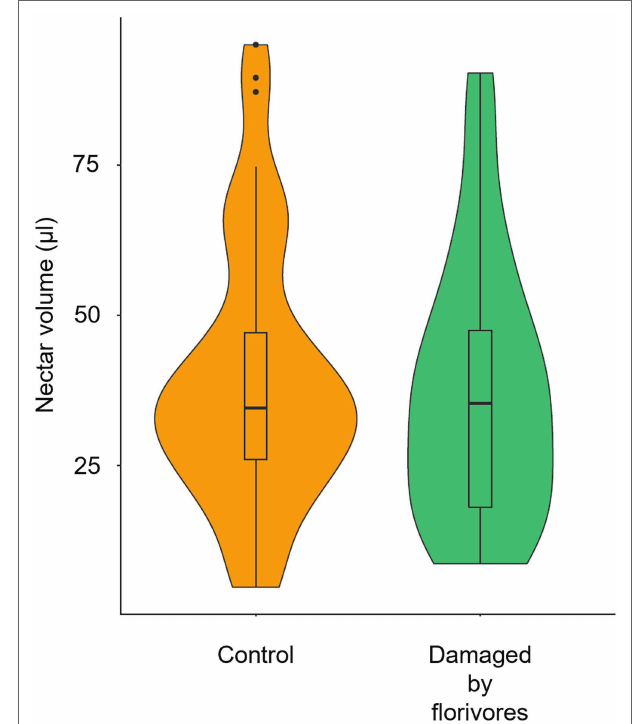
FIGURE 7 | Violin plots of nectar volume in Pyrostegia venusta flowers that were intact (control) and damaged by florivores. The median, the 25th and 75th percentiles, the non-outlier range (within 1.5 times the interquartile range), and the outliers are shown. There was no significant difference among the nectar volume in flowers submitted to the different treatments (GLMM with gamma error distribution, p =